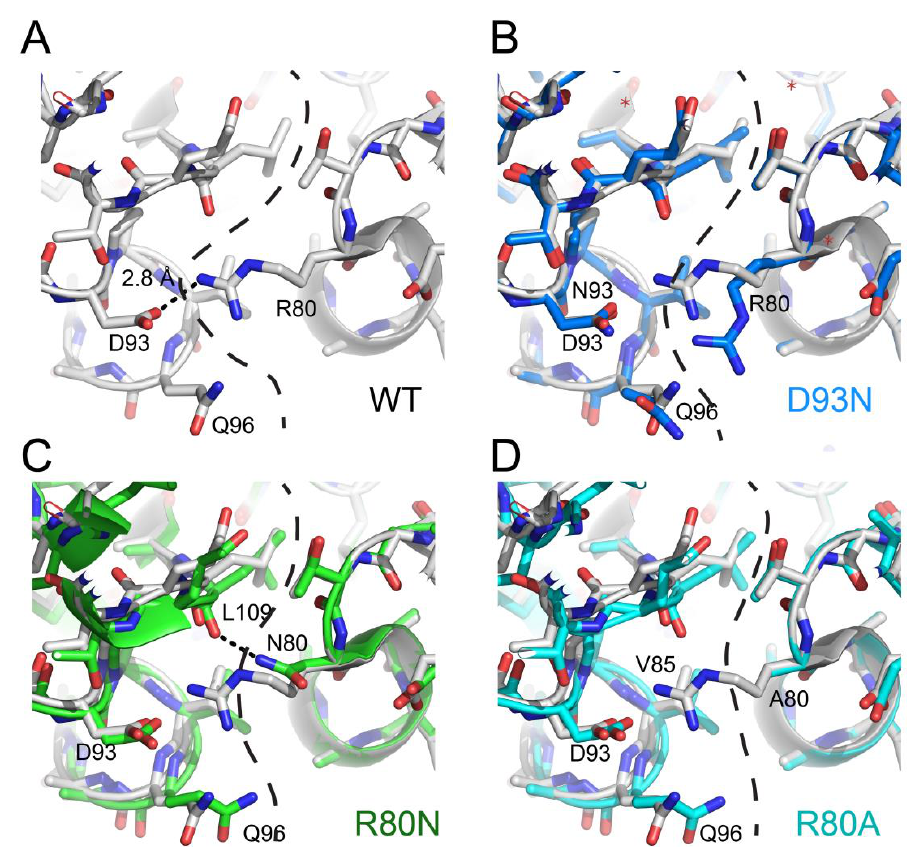
Figure 4. Stabilizing mechanisms induced by mutations at subunit interfaces of M. tuberculosis NDPK. ( A ) WT (wild type; white), ( B ) D93N (marine) vs. WT (white), ( C ) R80N (green) vs. WT (white), and ( D ) R80A (cyan) vs. WT (white).